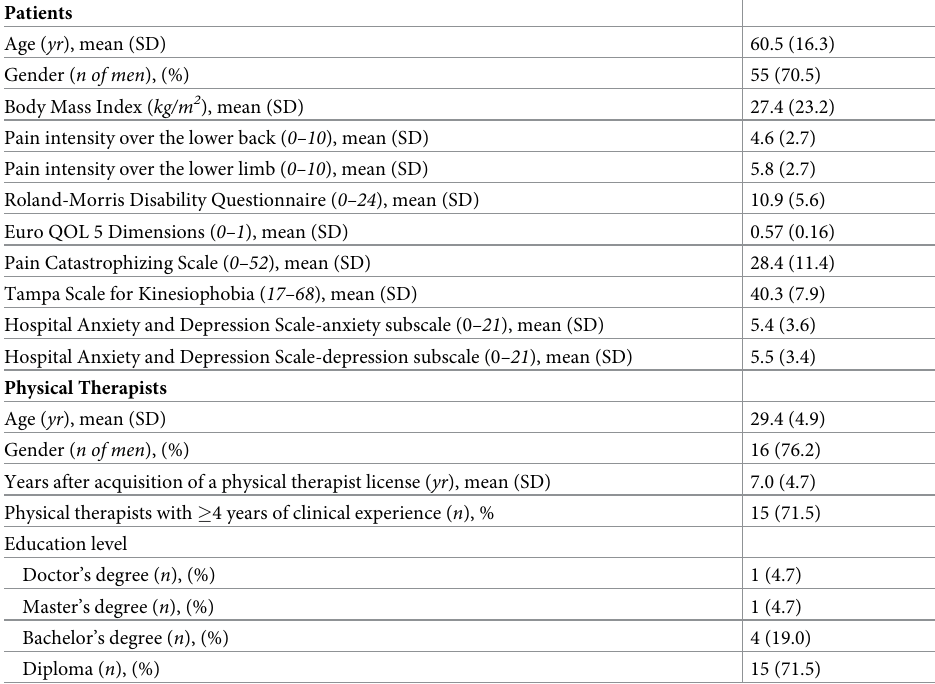
Table 1. Characteristics of the 78 patients and 21 physical therapists.